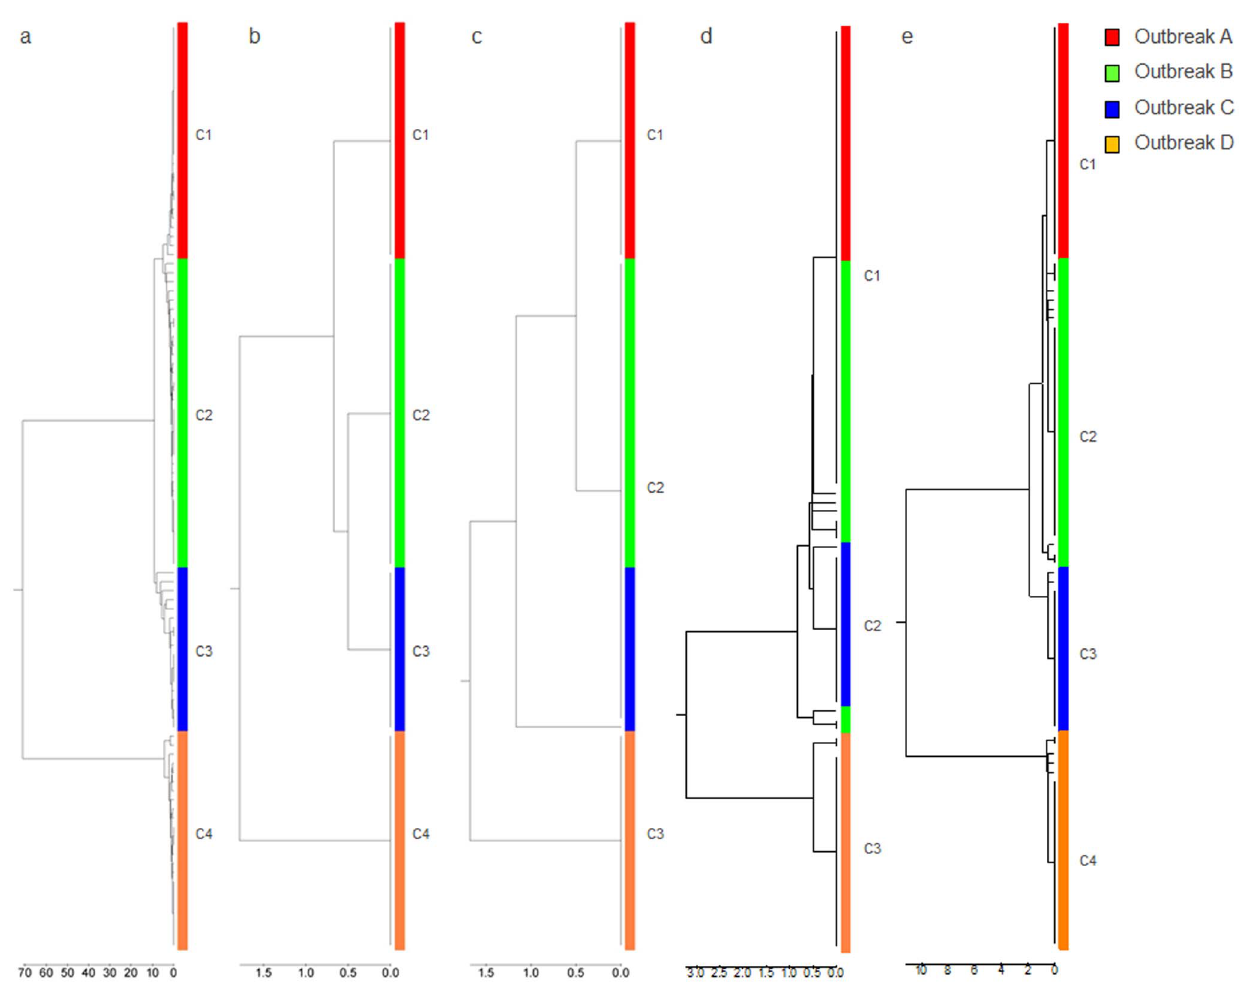
Figure 1. Phylogenetic analysis using different subgenomic regions. Phylogenetic analysis using sequences of (a) WG, (b) VP1/P2B, (c) 5 9 - UTR, (d) N-terminus of the VP1 gene and (e) entire VP1. doi:10.1371/journal.pone.0074546.g001 HAV genome. The amplicons were then used as templates for second-round PCR using SYBR Green Perfecta kit (Quanta BioSciences, Gaithersburg, MD). PCR primers sequences are Table 2. Nucleotide distances among HAV full-length genome outbreak strains.